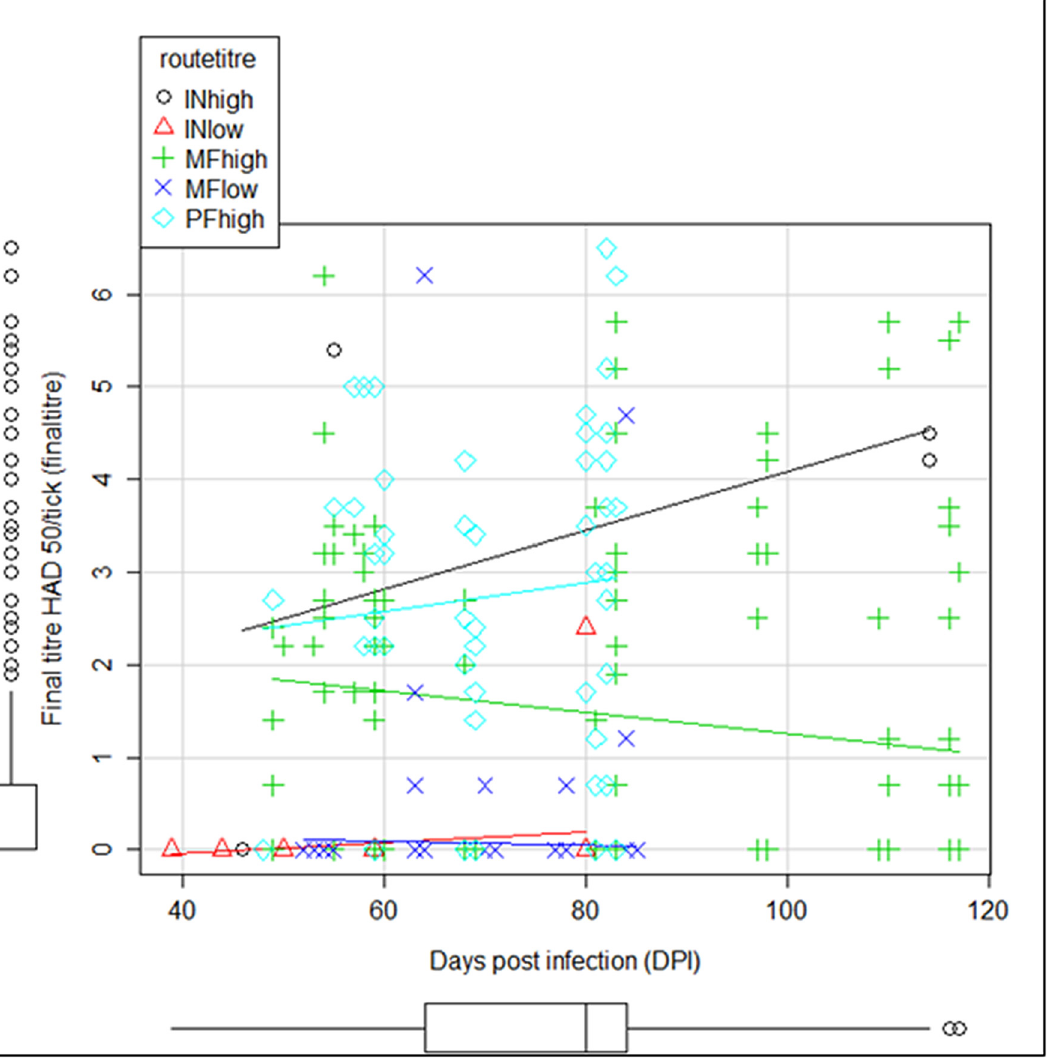
Fig 1. Scatterplot showing the variation of the final titre of virus in ticks (HAD 50 /Tick) between 39 days post infection and the end of the experiment per group — ticks inoculated with high and low titres of virus (INhigh and INlow); ticks that fed on membranes infected with high and low titres of virus (MFhigh and MFlow) and ticks that fed on pigs infected with high titres of virus